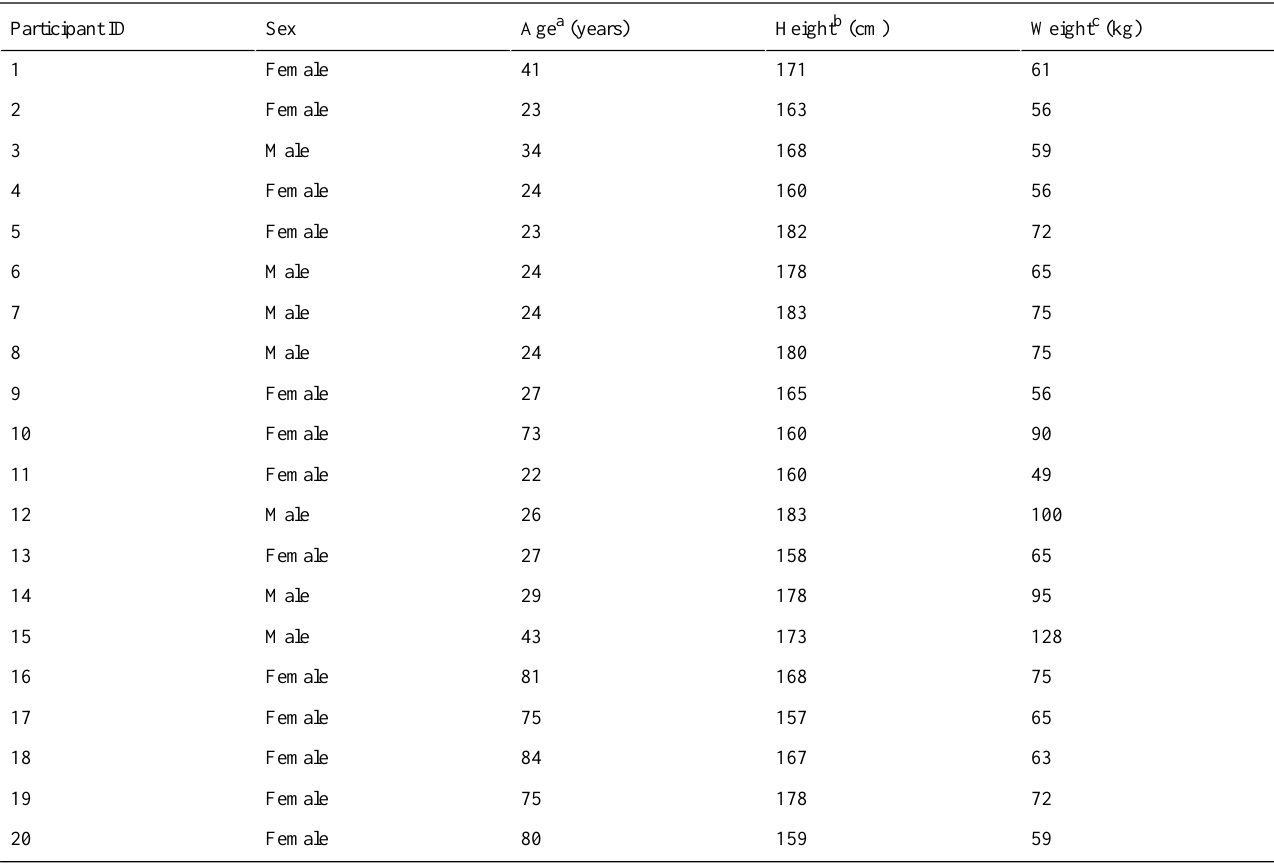
Table 1. Participant demographics (N=20; 13 female and 7